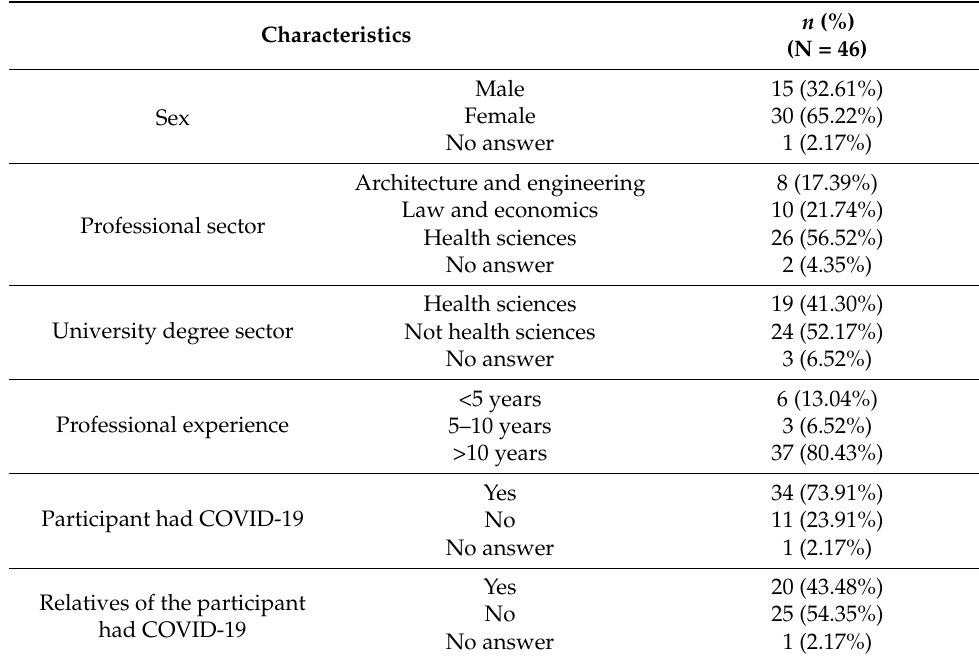
Figure 2. Robot hardware diagram and its functions. Table 3. Characteristics of